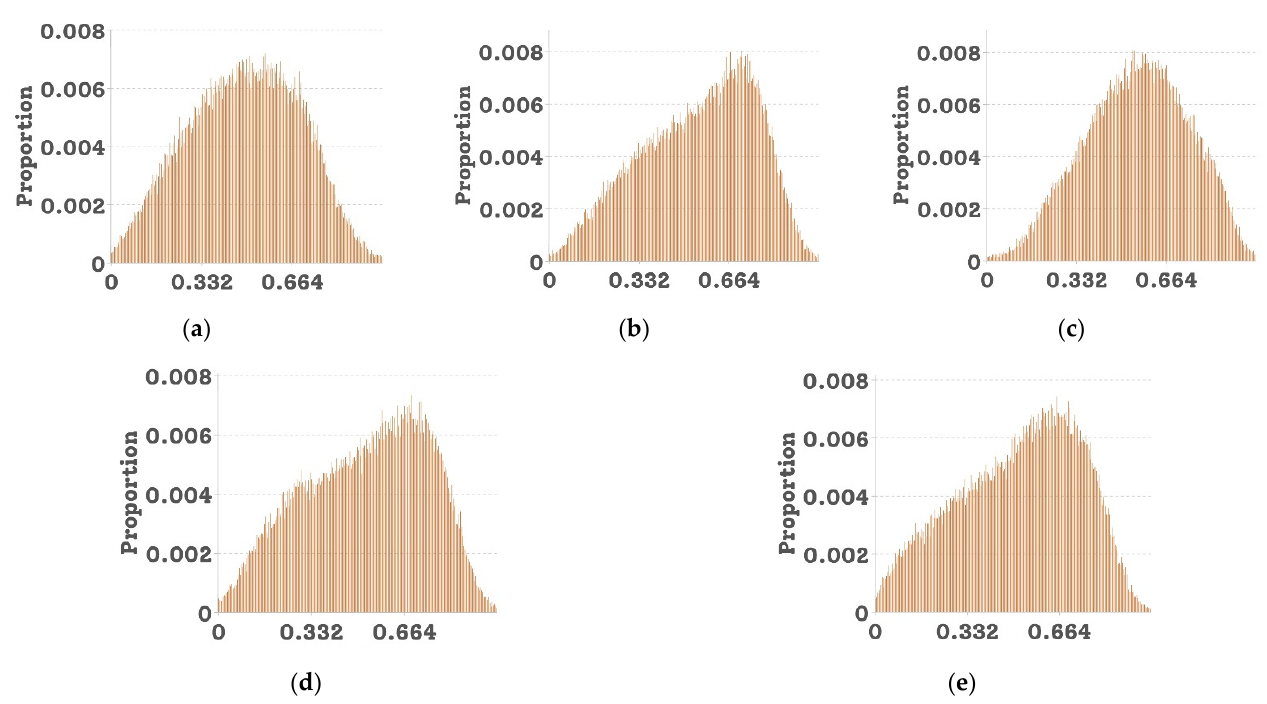
Figure 10. Vegetation coverage of grassland in different years. ( a ) In 1990; ( b ) In 2000; ( c ) In 2005; ( d ) In 2010; ( e ) In 2020.